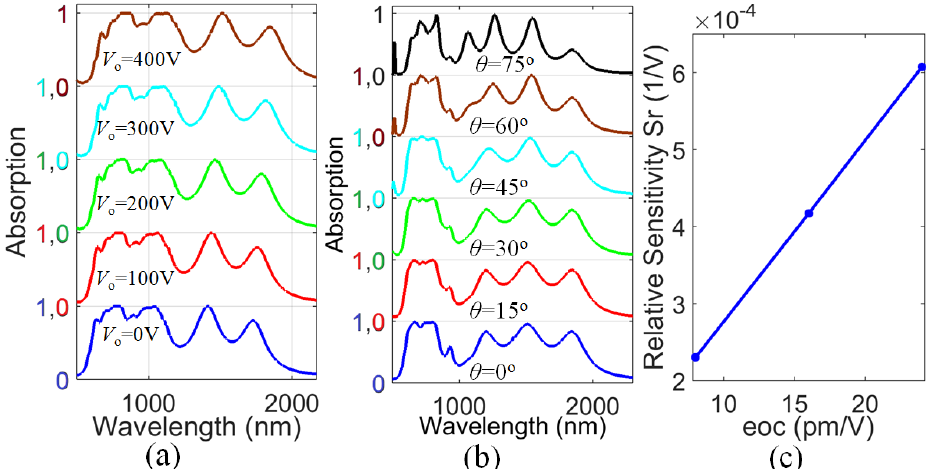
Figure 4. (a) Absorption spectra of different applied voltages V0 at CS = 60 nm and r = 90 nm; (b) Figure 4. ( a ) Absorption spectra of different applied voltages V 0 at CS = 60 nm and r = 90 nm; ( b ) influence of incident angle θ on absorption, and ( c ) relative sensitivity at different eoc influence of incident angle θ on absorption, and (c) relative sensitivity at different eoc values.